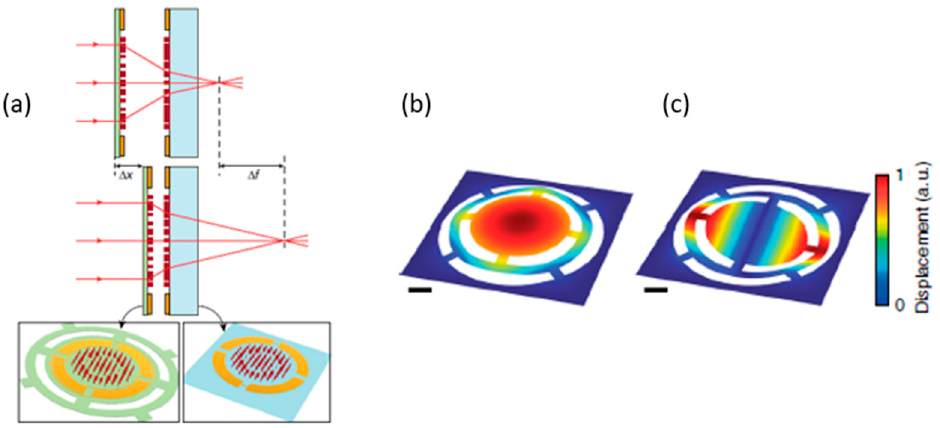
Figure 9. Metasurface-based MEMS device wit tunable focus. ( a ) Schematic illustration of the proposed tunable lens, comprised of a stationary lens on a substrate, and a moving lens on a membrane. The first ( b ) and second ( c ) mechanical resonances of the membrane at frequencies of 2.6 and 5.6 kHz, respectively. The scale bars are 100 µ m. (Reproduced from [49] with permission.)